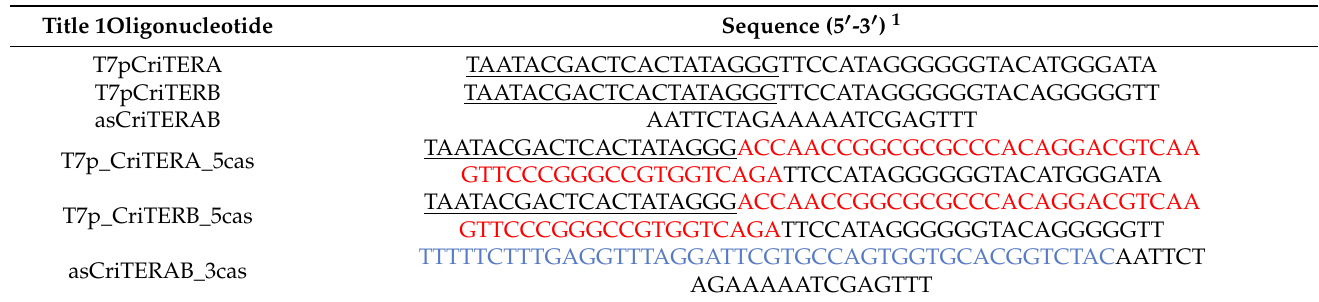
Table 1. Oligonucleotides used in this